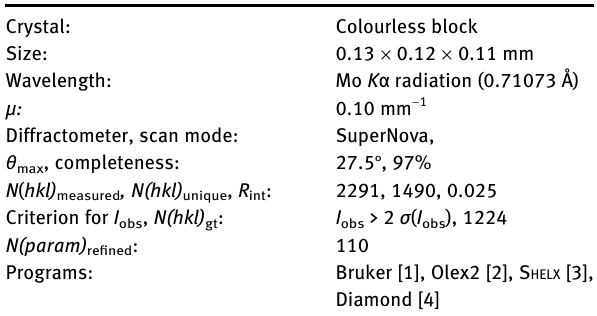
Table  : Fractional atomic coordinates and isotropic or equivalent isotropic displacement parameters (Å 